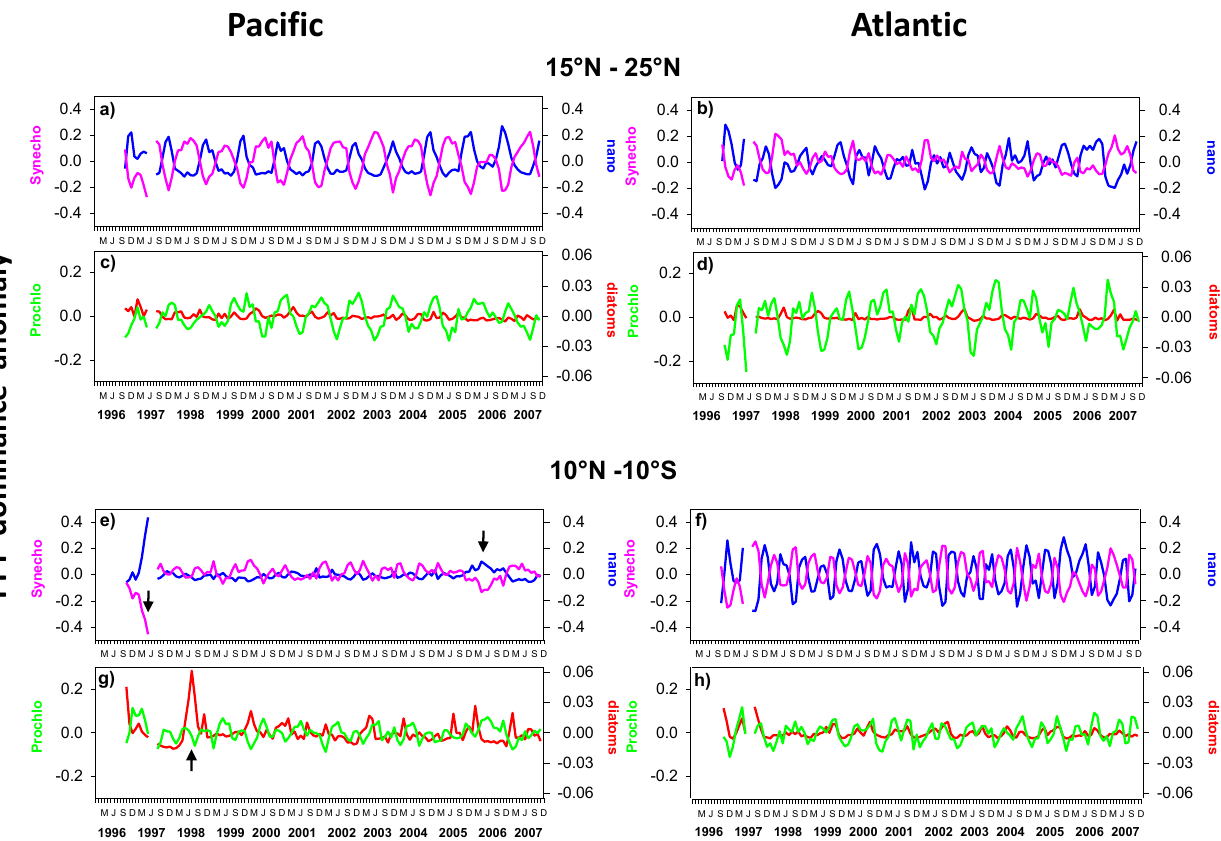
Fig. 5. The PFT dominance anomaly at tropical (15 ◦ N–25 ◦ N) and equatorial (10 ◦ N–10 ◦ S) latitudes in the Pacific and Atlantic Oceans (over 1996–2007) using the OCTS and SeaWiFS datasets. The PFT anomaly was generated from monthly maps of the relative frequency of the identified dominant phytoplankton group within each 1 ◦ × 1 ◦ grid box. The longitudinal extent of the tropical regions was 180 ◦ W to 100 ◦ W, 80 ◦ W to 20 ◦ W for Pacific and Atlantic regions, respectively. The extent of the equatorial regions was 180 ◦ W to 80 ◦ W, 45 ◦ W to 11 ◦ E for Pacific and Atlantic regions, respectively. Arrows show the main maximum shift between Synechococcus and nanoeucaryotes during the early stages of El Ni˜no (arrow in panel e) and for diatoms during La Ni˜na (arrow in panel